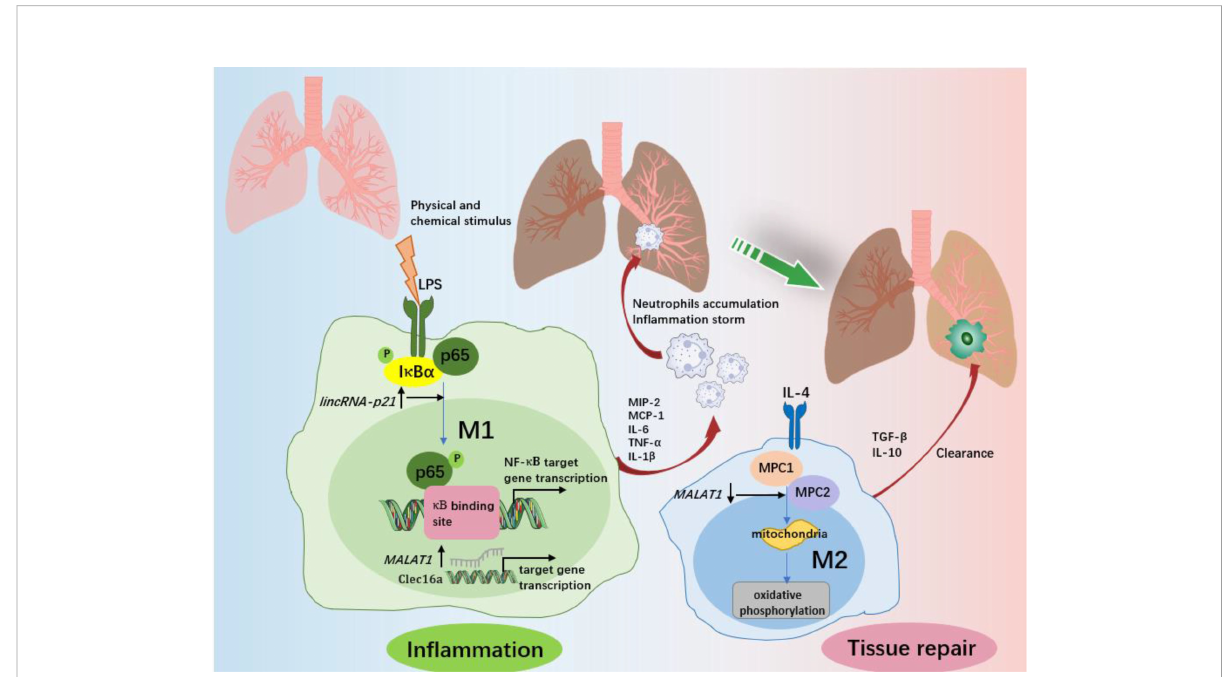
FIGURE 4 The role of macrophages and associated lncRNAs in ALI/ARDS. In response to various physicochemical stimuli, M1 macrophages release various proin fl ammatory cytokines at the site of in fl ammation and then recruit neutrophils from the circulation into the lung and alveolar spaces. Excess accumulation of proin fl ammatory factors and neutrophils promotes the progression of in fl ammation and lung injury. LincRNA-p21 contributes to LPS-induced M1 activation by promoting the ubiquitination of I k B a , activating NF- k B as well as promoting p65 nuclear translocation. MALAT1 promotes the expression of C-type lectin domain family 16, member A (Clec16a) in nucleus, which is required for the proin fl ammatory activation of M1 macrophages. After the elimination of the trigger, macrophages changed from the M1 to the M2 phenotype, and ALI/ARDS entered the recovery stage. M2 macrophages play an important role in in fl ammation resolution and lung tissue repair by limiting the levels of proin fl ammatory cytokines and enhancing the production of anti-in fl ammatory cytokines. MALAT1 regulation of M2 activation of macrophages is dependent on glucose metabolism. Both mitochondrial pyruvate carriers (MPC)1 and MPC2 are upregulated by IL-4. IL-4 downregulates MALAT1 expression, and MALAT1 knockdown enhances the expression of MPC1 and MPC2, therefore regulating glucose-derived mitochondrial oxidative phosphorylation (OxPhos), which is essential to M2 macrophage